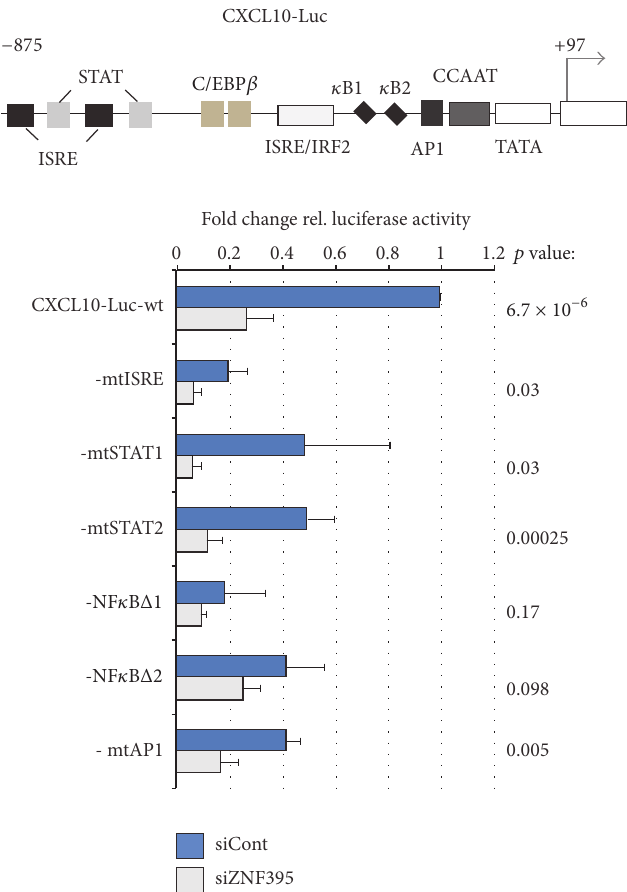
Figure 5: ZNF395 requires intact NF 𝜅 B motifs to enhance CXCL10 expression. RTS3b cells were cotransfected with the wt CXCL10 promoter-luciferase reporter construct or CXCL10 promoter-luciferase reporter constructs containing mutations within the binding sites of the indicated transcription factors and either 7.5 pmol siRNA against ZNF395 or the same amount of control siRNA. 48 h later the firefly luciferase activity was determined and normalized against the protein concentration of each sample. The relative luciferase activity of the wt CXCL10 promoter in the presence of siControl was set as 1 and the fold activations of the mutated constructs after cotransfection of control siRNA or siRNA against ZNF395 were calculated. The graph represents the average of 6 independent assays. The standard deviations are given. The 𝑝 values calculated by the 𝑡 -test for paired samples are